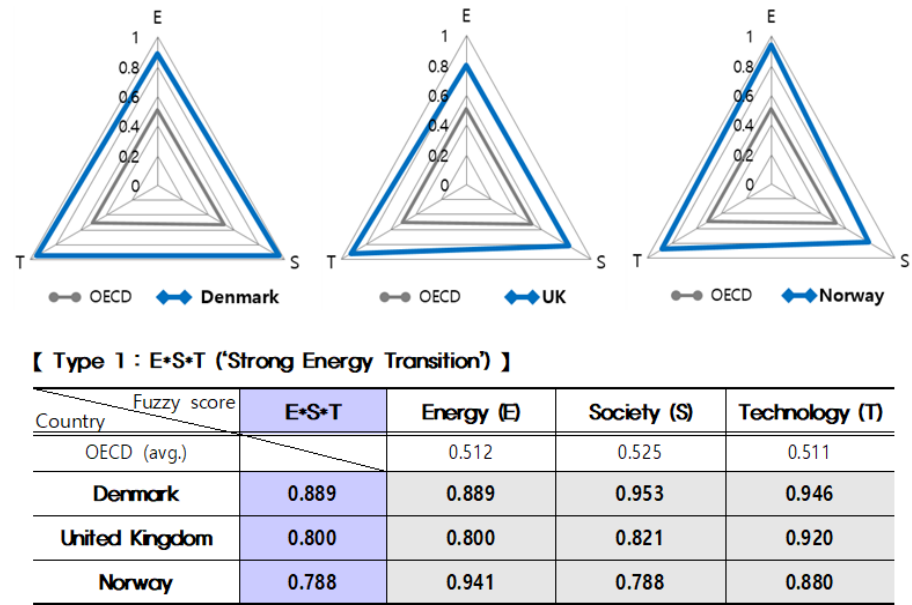
Figure 2. Comparison of main results by OECD countries: Type 1.